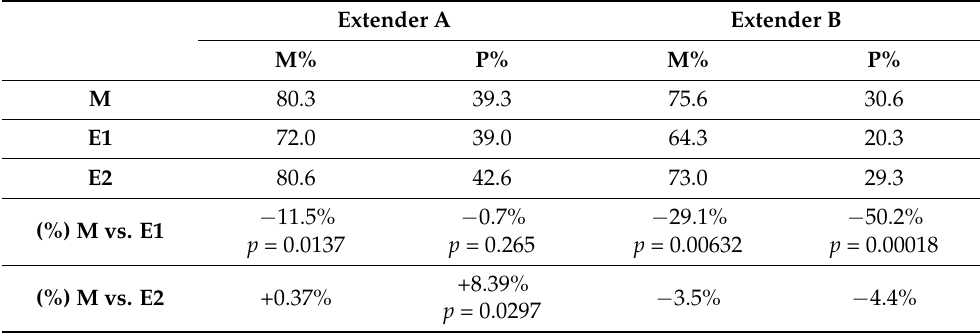
Table 5. Assessment of compatibility between semen extenders and different concentrations in flu-